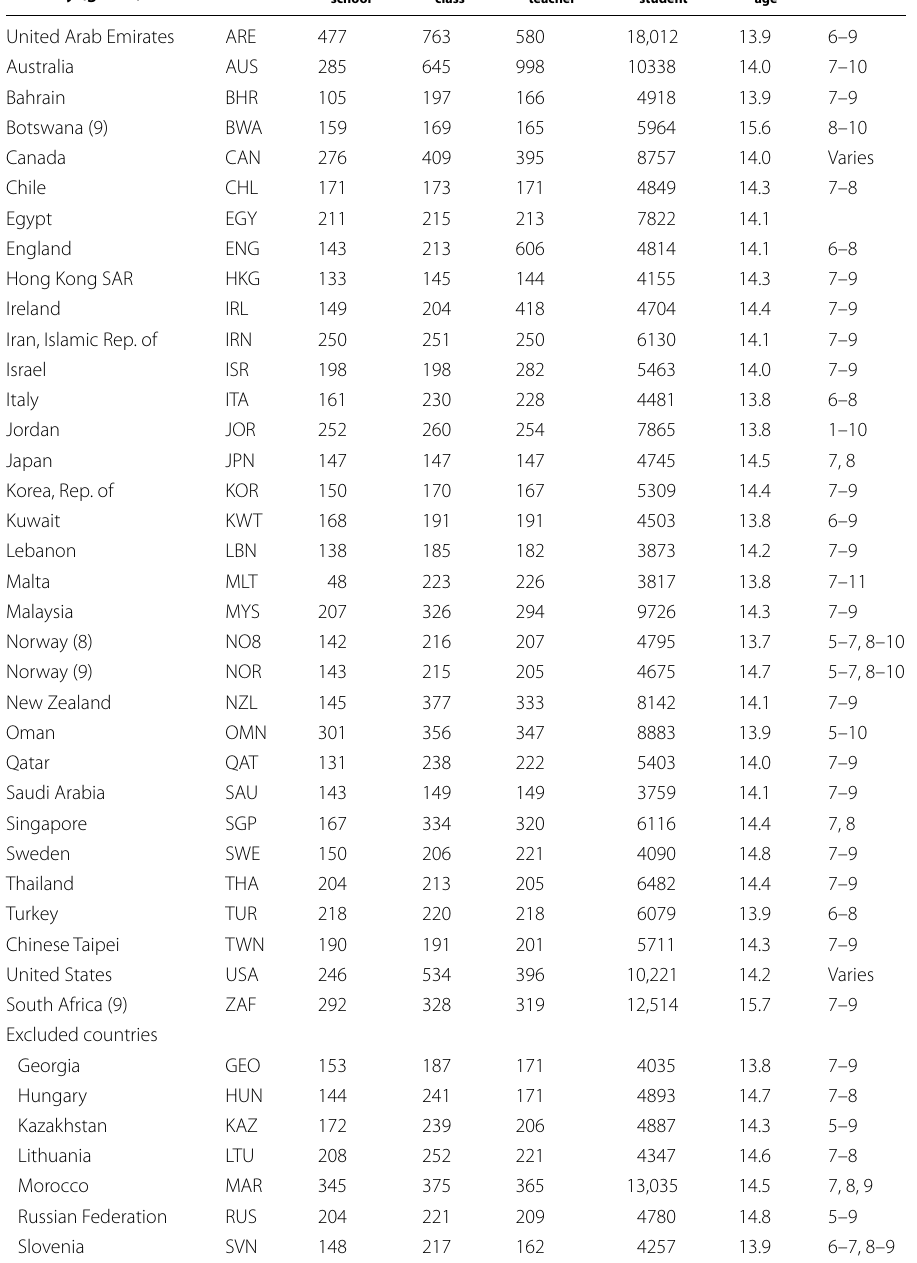
Table 1 Country-specific information for TIMSS 2015